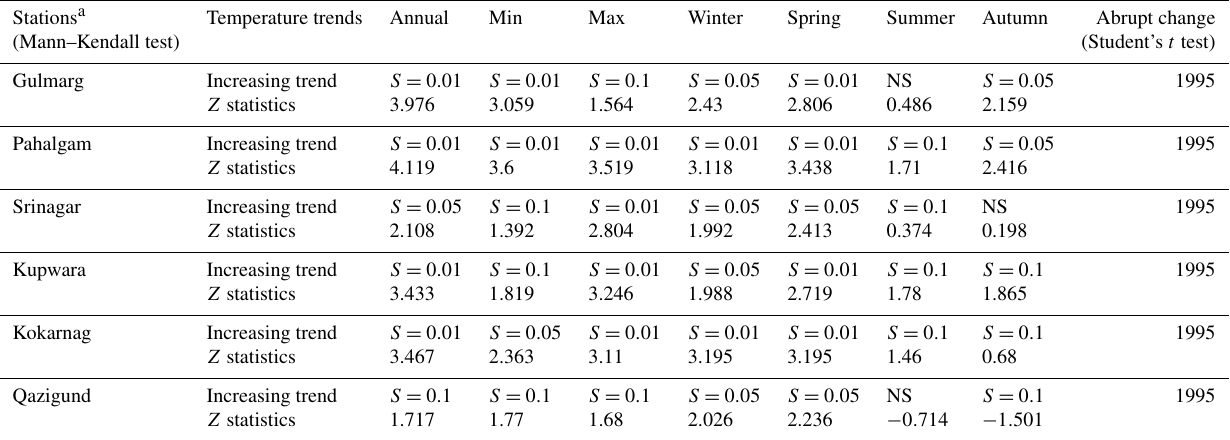
Table 1. Annual and seasonal temperature trends in the Kashmir Valley during 1980–2016. Stations a